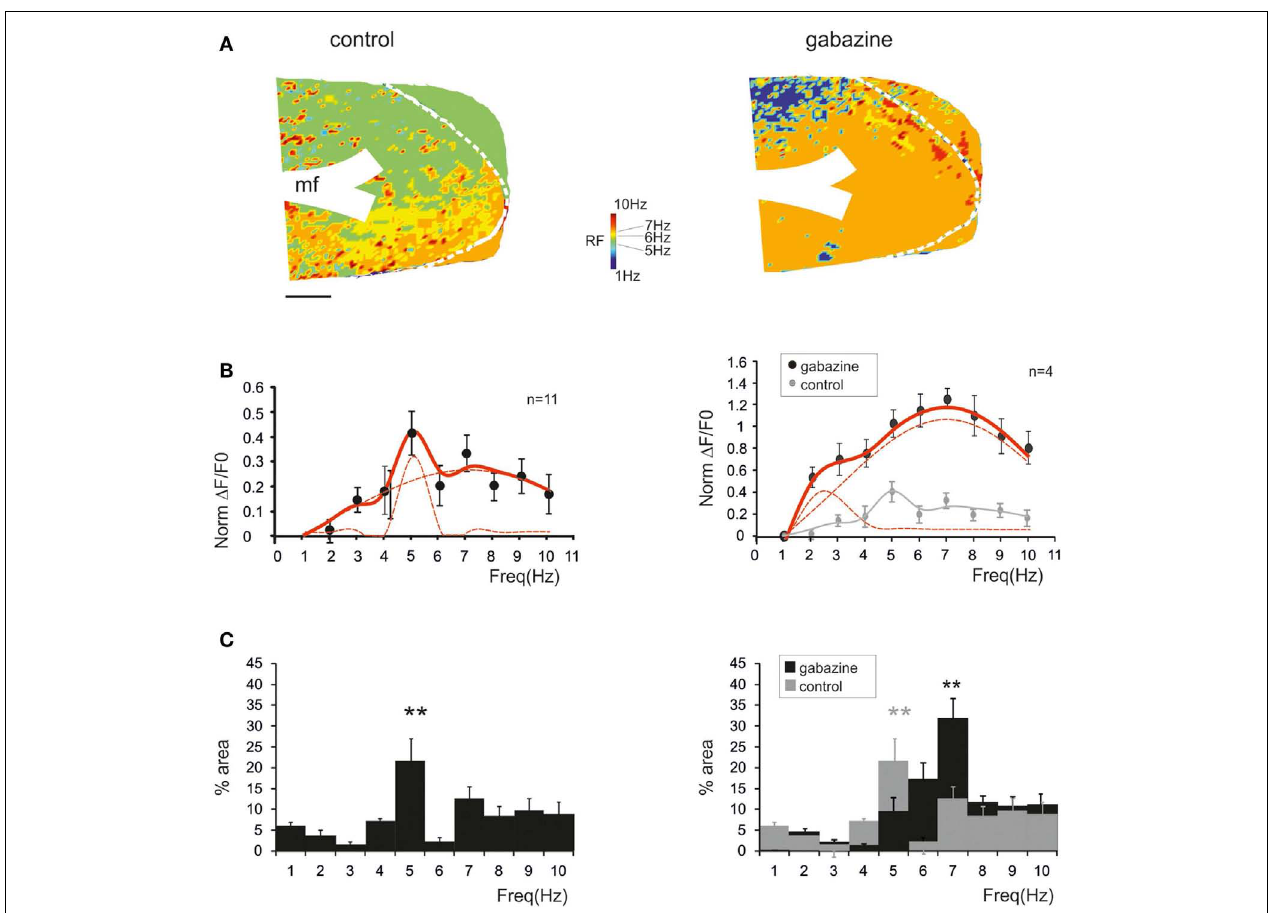
range.The amplitude of the resonance plot increases after gabazine. (C) Histograms report the relative areas covered by each RF averaged over several recordings ( n = 11 control and n = 4 gabazine). Note that the main peak in control occurs at 5Hz but moves to 7Hz in the presence of gabazine. Data are reported as mean ± SEM. Red lines fitting the data point represent double Lorentzian functions (broken lines are the two individual component functions) obtained on control and gabazine data,